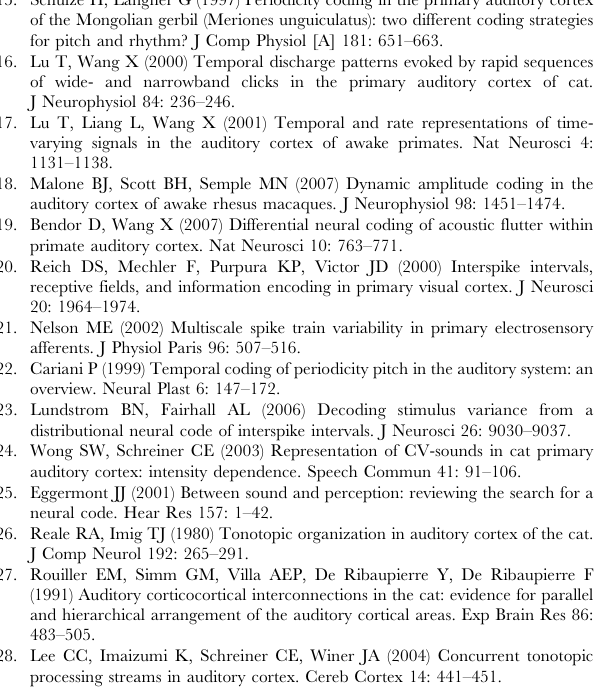
Figure S3 Smoothed tonotopic gradient and approximate position of AAF. (A) Hemisphere 073L. (B) Hemisphere 073R. Scale bars: 1 mm. See Figure 4’s legend for further explanation. Found at: doi:10.1371/journal.pone.0011531.s003 (0.19 MB TIF) Figure S4 Spatial distributions of population response (without smoothing) to different repetition rates (hemisphere 111L). Spatial representation of raw VS (A), normalized FR (B), and raw CV of ISI (C) as a function of different repetition rates. Scale bars: 1 mm. See Figure 4’s legend for further explanation. Found at: doi:10.1371/journal.pone.0011531.s004 (0.86 MB